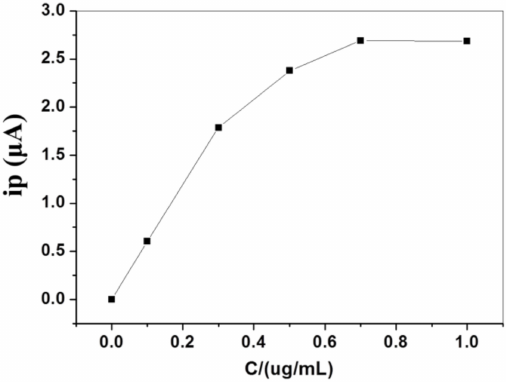
Figure 6. The relationship between the ST-AP concentration and the peak current under the reaction with 5.0 × 10 2 CFU/mL E. coli .